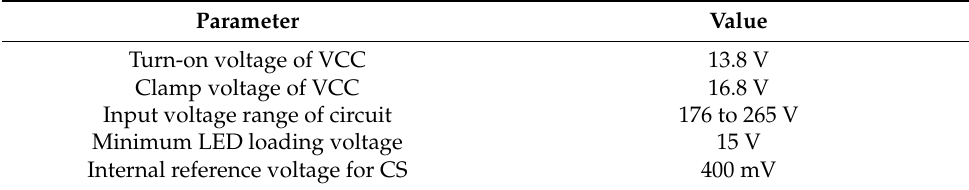
Table 3. Specifications of IC